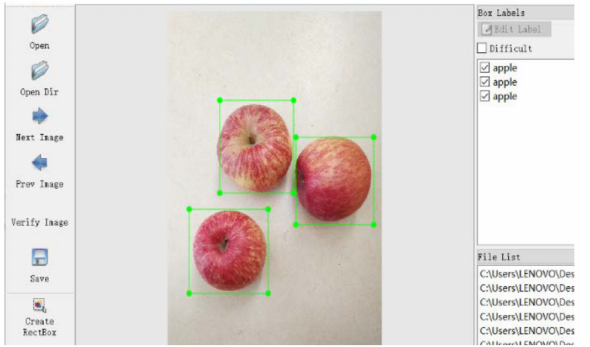
Figure 6. The annotation of the dataset. The ground truth of apple is green bounding boxes. As an image annotation tool, LabelImg can save the generated annotation as an XML file in Pascal VOC format without secondary